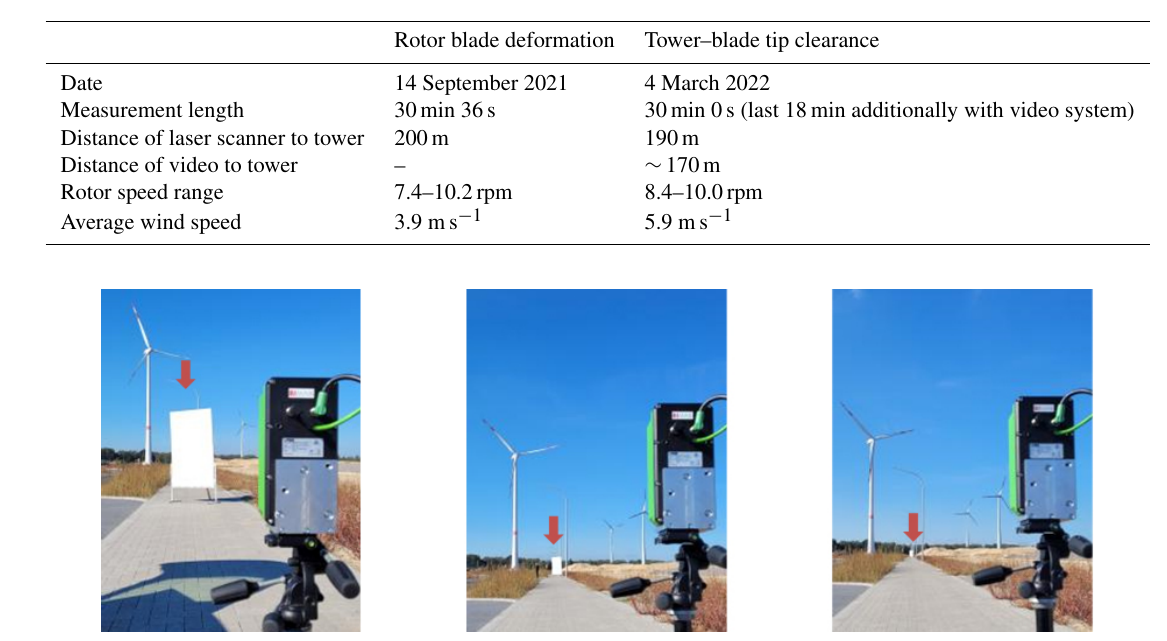
Table 4. Measurement conditions for the different experiments.